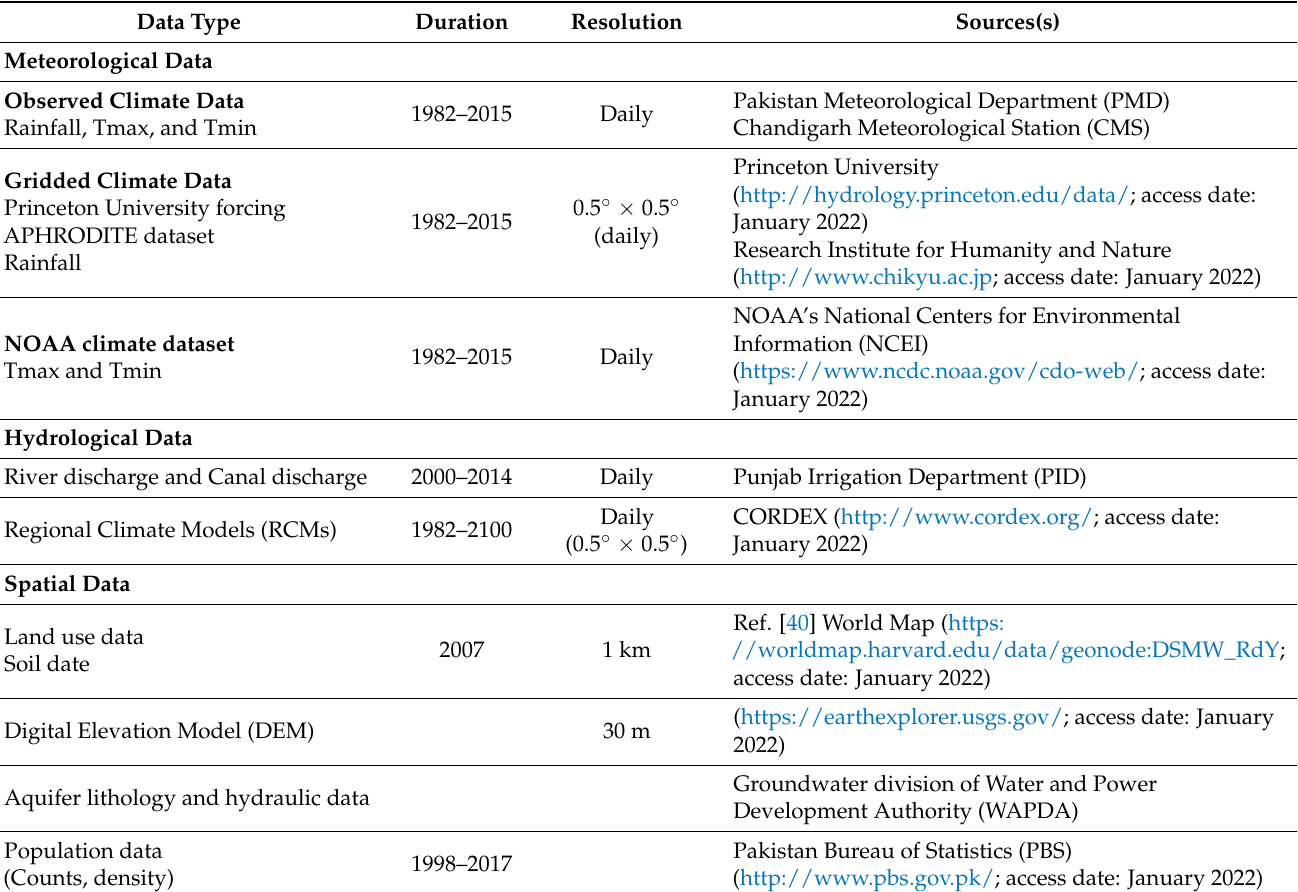
Table 1. Data required for assessment of the impact of future climate, land use, and abstraction on groundwater resources in